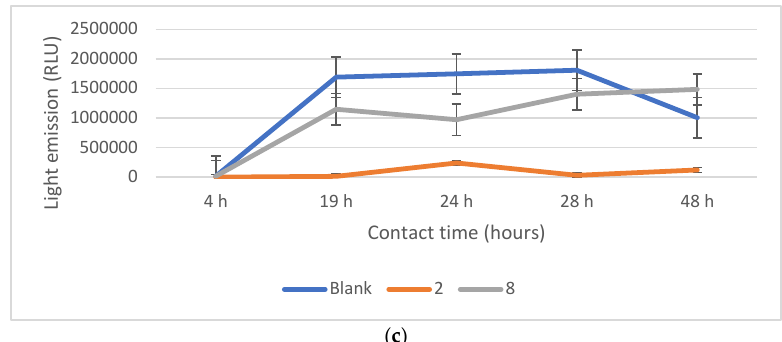
Figure 5. Light emission from bacteria in contact with the untreated solutions (blank) and the solutions after 2 h and 8 h of irradiation. ( a ) TBA, ( b ) IMI, ( c ) AZO. Both solutions of TBA, at 2 and 8 h, reduced the light emission to zero, confirming that the important decrease in the active ingredient concentration was ineffective in re- ducing the toxicity of this compound, a characteristic probably completely retained by its photoproducts. On the contrary, the sample of IMI collected after 2 h of treatment still completely inhibited the light emission, confirming the solution toxicity, but the sample at the end of the treatment showed no inhibition. The light intensity was practically overlapped with that of the control. The incomplete mineralization of the solution did not represent a prob- lem of residual toxicity from the degradation products.